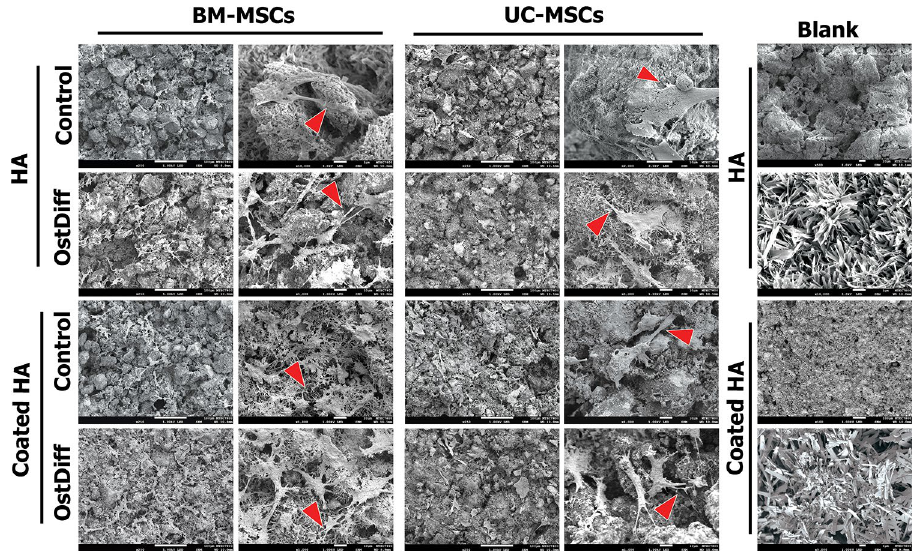
Figure 5. Scanning electron microscopic images demonstrate the characteristics of BM-MSCs and UC-MSCs cultured with osteogenic differentiation medium on 3D-printing HA (HA) and coated 3D-printing HA (coated HA) compared to the cells cultured with complete DMEM medium for 28 days. The cells attach to the scaffolds and become large-flatten cells with extended and interconnected cytoplasmic processes (red